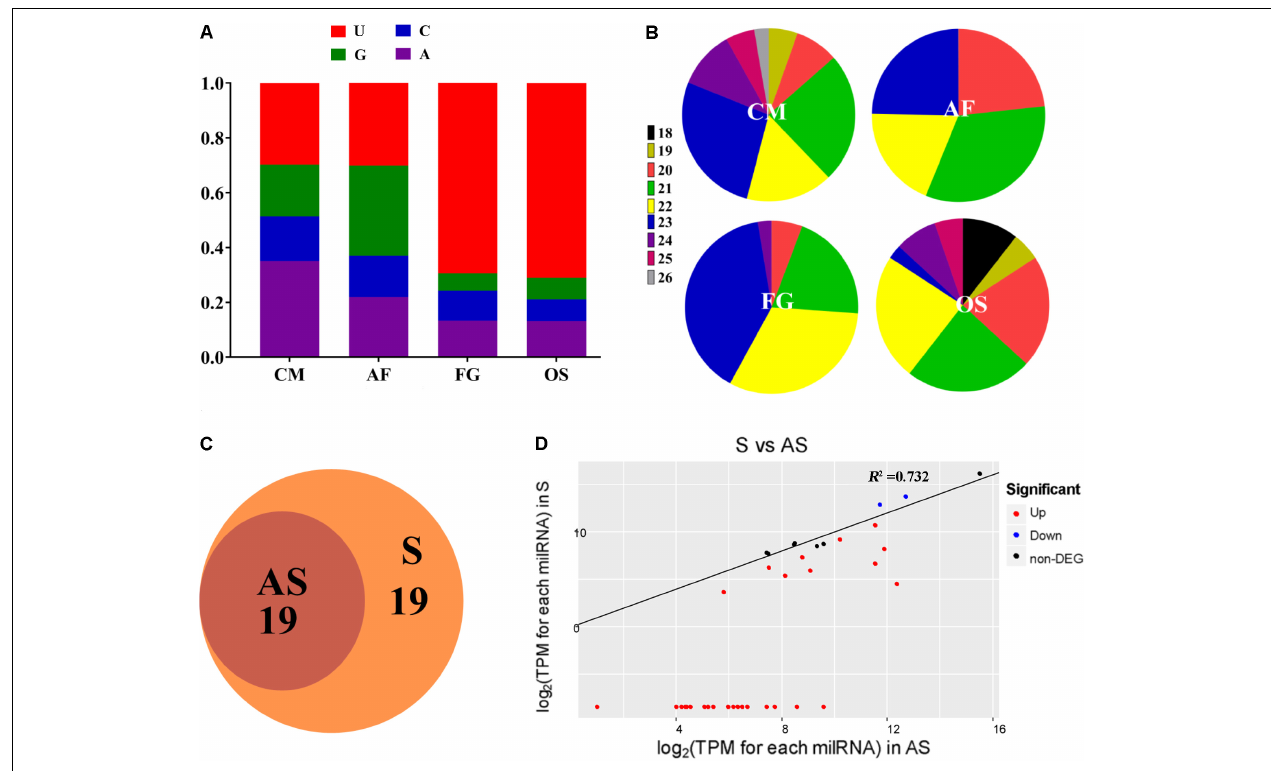
FIGURE 2 | Characteristics and expression of milRNAs in C. militaris . (A) 5 (cid:48) -terminal nucleotide of milRNAs among different fungi. CM, Cordyceps militaris ; OS, Ophiocordyceps sinensis ; AF, Aspergillus flavus ; FG, Fusarium graminearum . The y -axis shows the proportion of 5 (cid:48) -terminal nucleotides consisting of G/C/A/U. (B) The percentages of size distributions of the milRNAs among different fungi. (C) The Venn diagram illustrates the number of milRNAs from asexual or sexual development stages. AS, asexual development; S, sexual development. (D) The expression levels of milRNAs in sexual and asexual development stages.